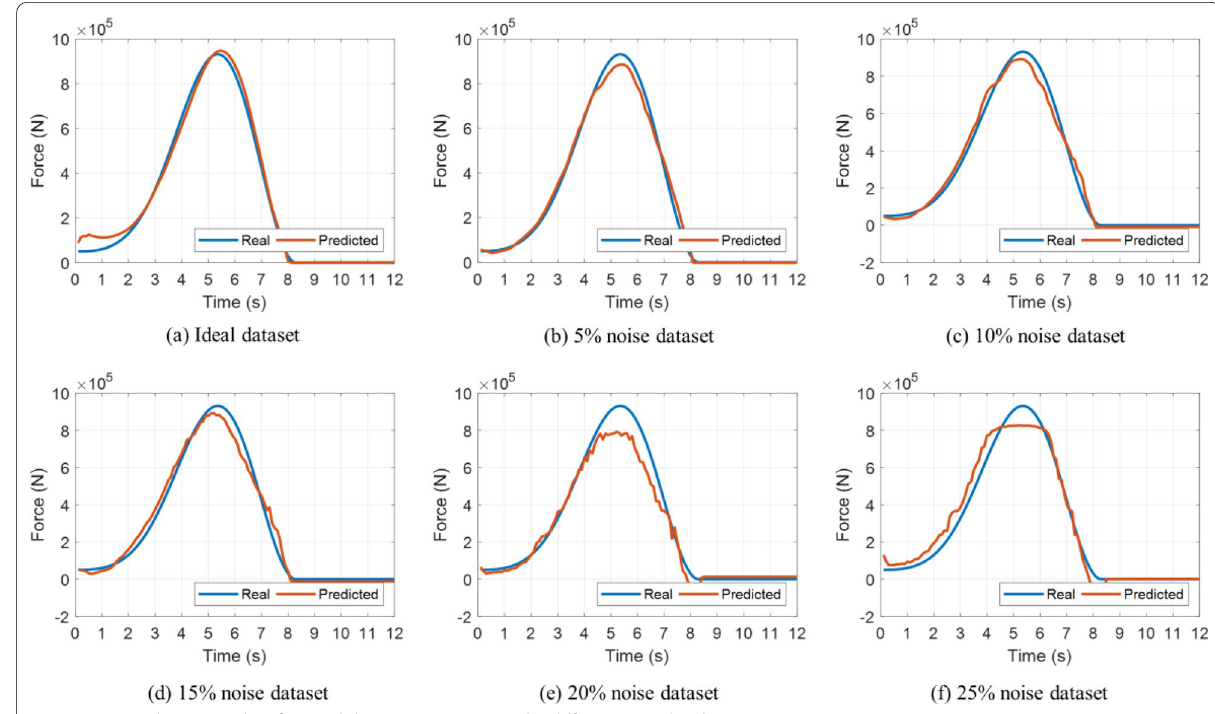
Figure 11 Prediction results of normal digging resistance under different noise levels